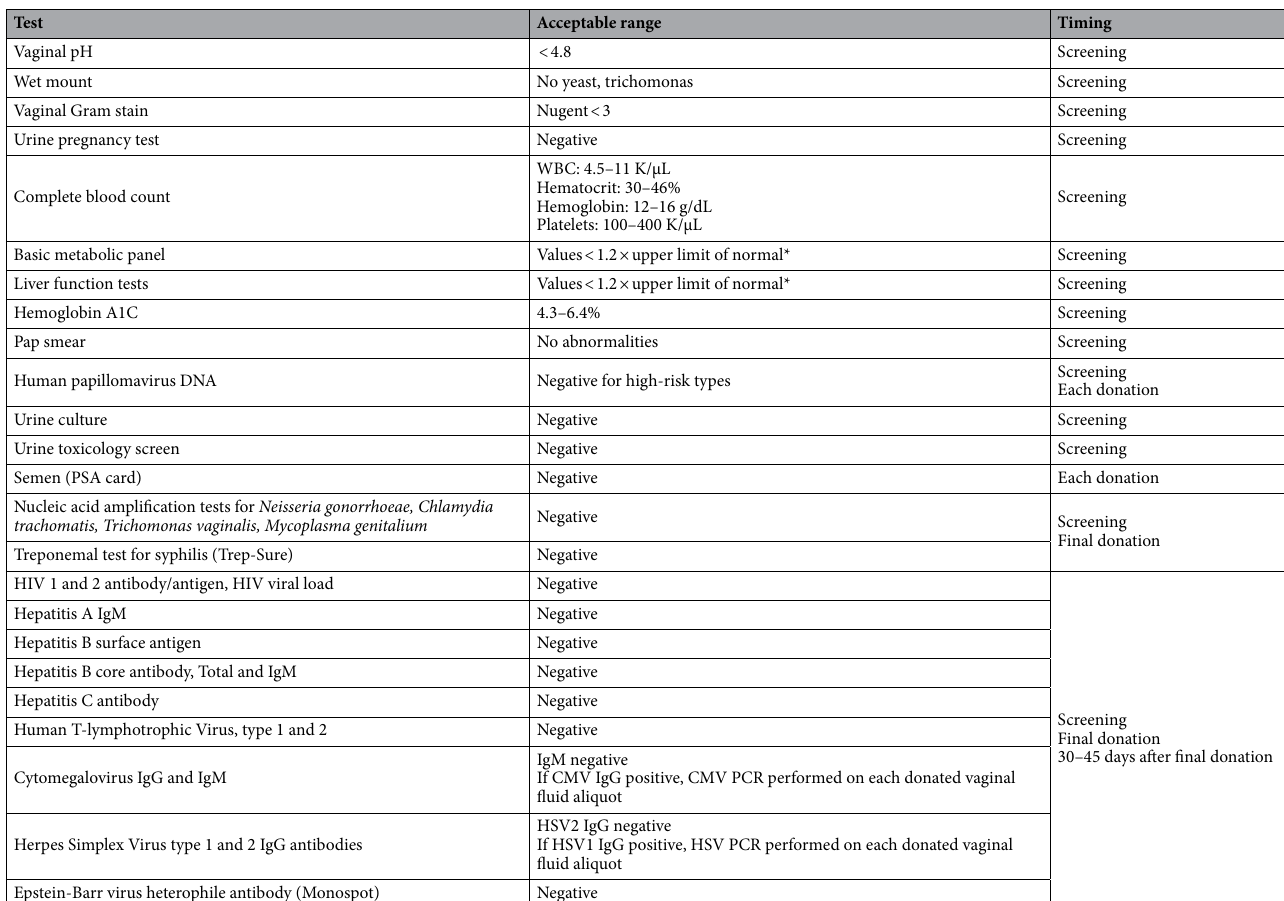
Table 1. Overview of donor screening tests. *Normal ranges in Table